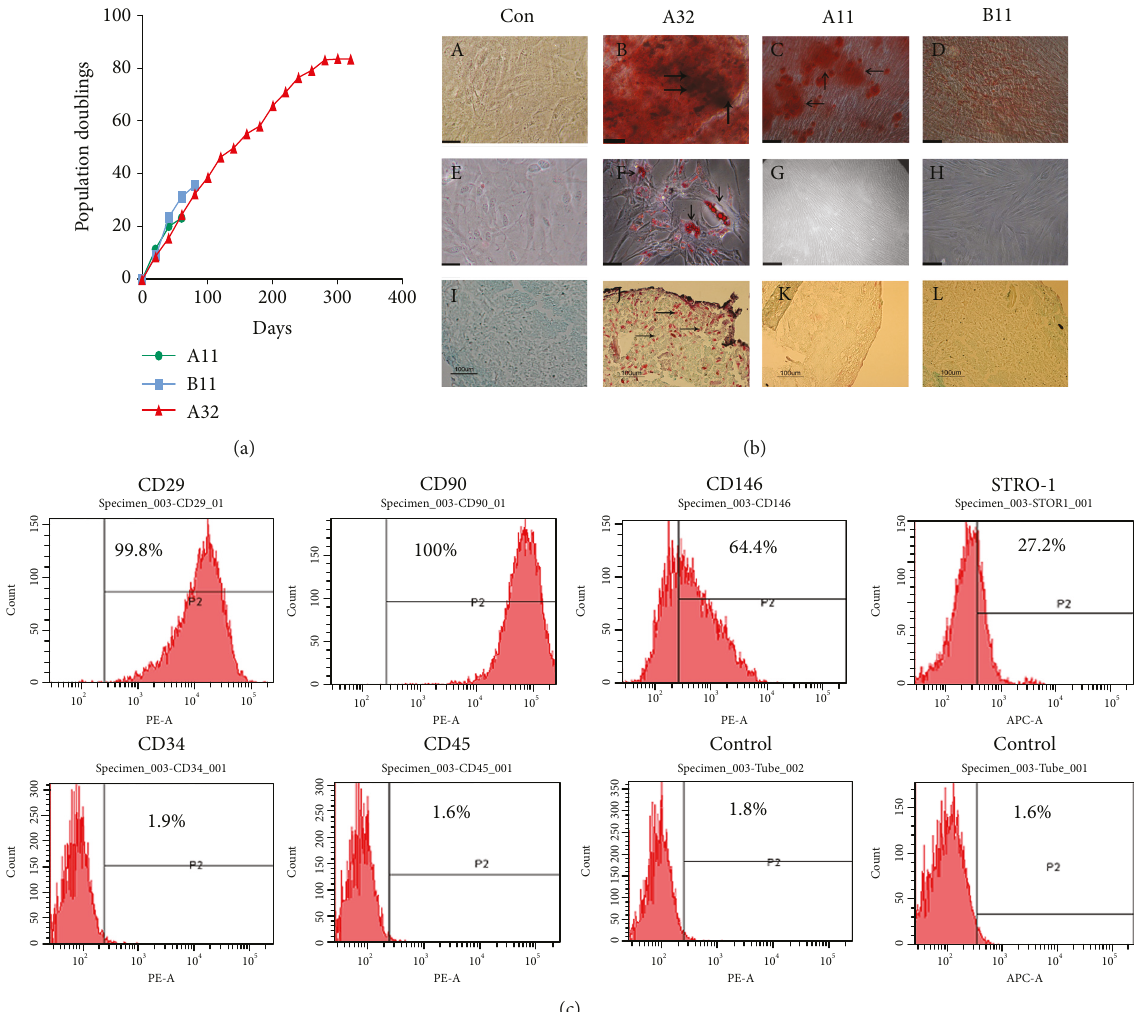
Figure 1: Theabilityofproliferationand di ff erentiation analysisfor three clonesofhuman dental pulp stemcells(DPSCs) (A11, B11, andA32) and characterization of A32. Population doublings (PDs) of three clones (A11, B11, and A32) from di ff erent patients (a). The di ff erentiating potential of the three clones into osteogenic (Alizarin Red staining) (b: B – D), adipogenic (Oil Red O staining) (b: F – H), and chondrogenic lineages (Safranin O staining) (b: J – L) when cultured in di ff erentiation condition compared to control groups, respectively (b: A, C, and I). A32 had the potential to di ff erentiate into osteogenic (b: B), adipogenic (b: F), and chondrogenic (b: J) lineages. A11 and B11 had the potential to di ff erentiate into osteogenic lineages (b: C and D). Analysis of molecular surface antigen markers in A32 by fl ow cytometry ( P2 -positive zone of antigen) indicated that A32 was negative for CD34 and CD45, whereas it was positive for CD29 and CD90; of cells, 64.4% were CD146-positive and 27.2% STRO-1-positive (c). PE- and APC-conjugated nonspeci fi c mouse IgG1 served as negative